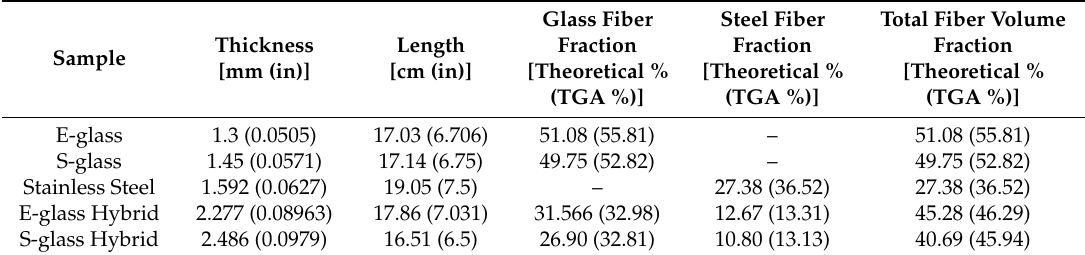
Table 2. Average composite thicknesses and fiber volume